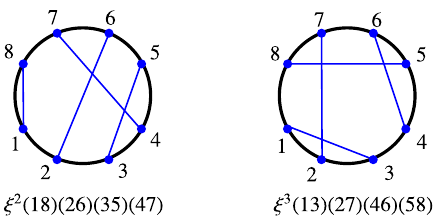
Figure 14 . Examples of contributions to the 8-pt correlation function of D 1 using the modi(cid:12)ed Wick contraction rule depending on a parameter (cid:24)